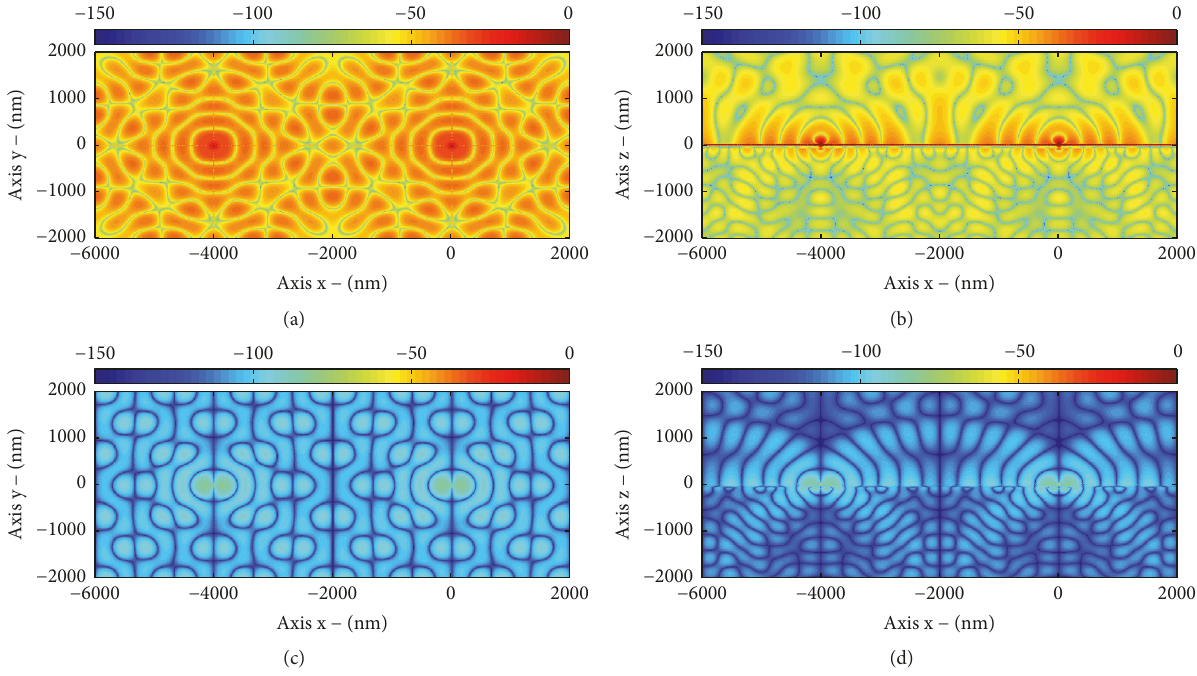
= 50𝑛𝑚 , ℎ = 20𝑛𝑚 , Δ = 4𝜇𝑚 , 𝜆 = 632.8𝑛𝑚 , 𝑔 𝑐